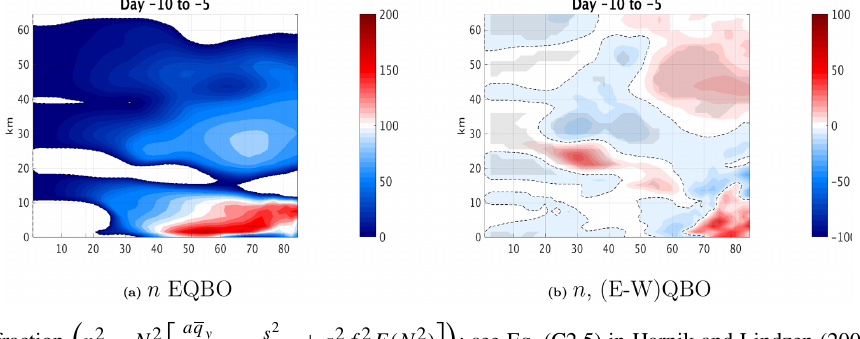
Figure 9. Index of refraction for (a) east QBO and (b) the difference between east and west QBOs in the 3DO 3 run.